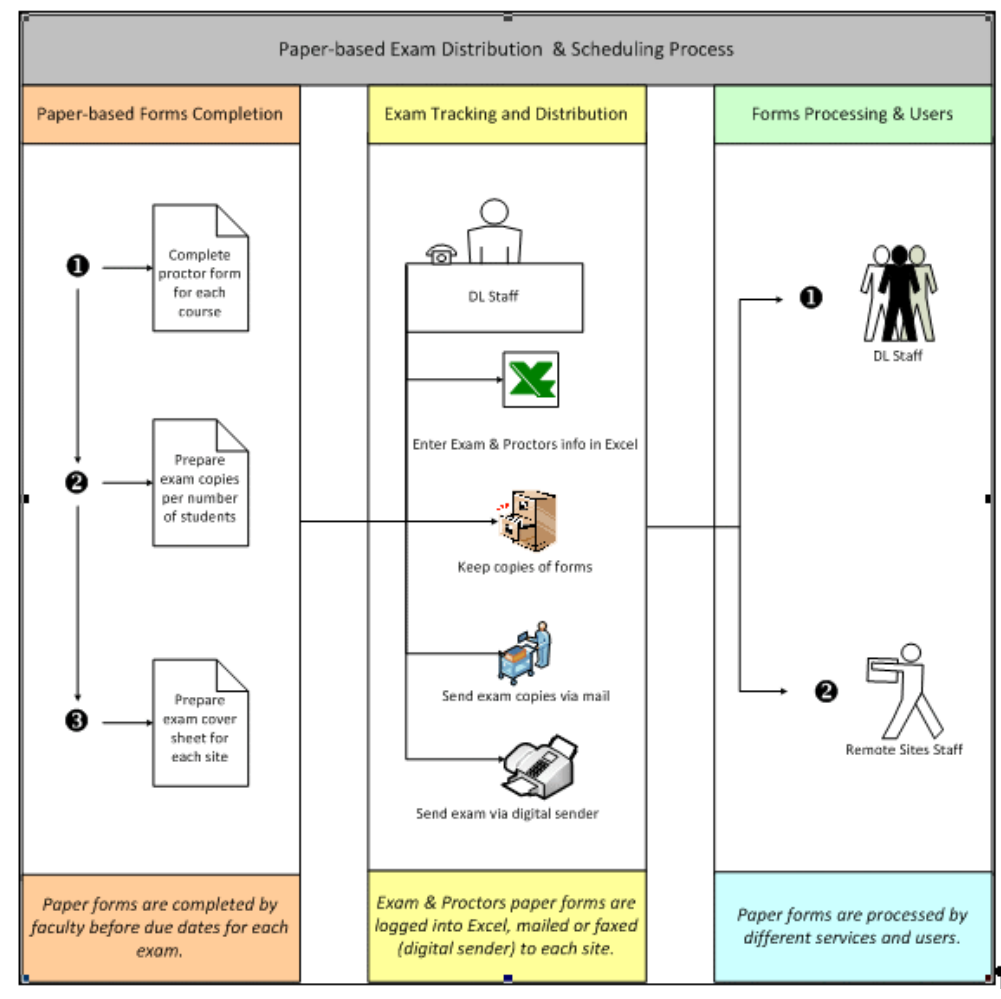
Figure 2. Paper-based exam distribution and scheduling